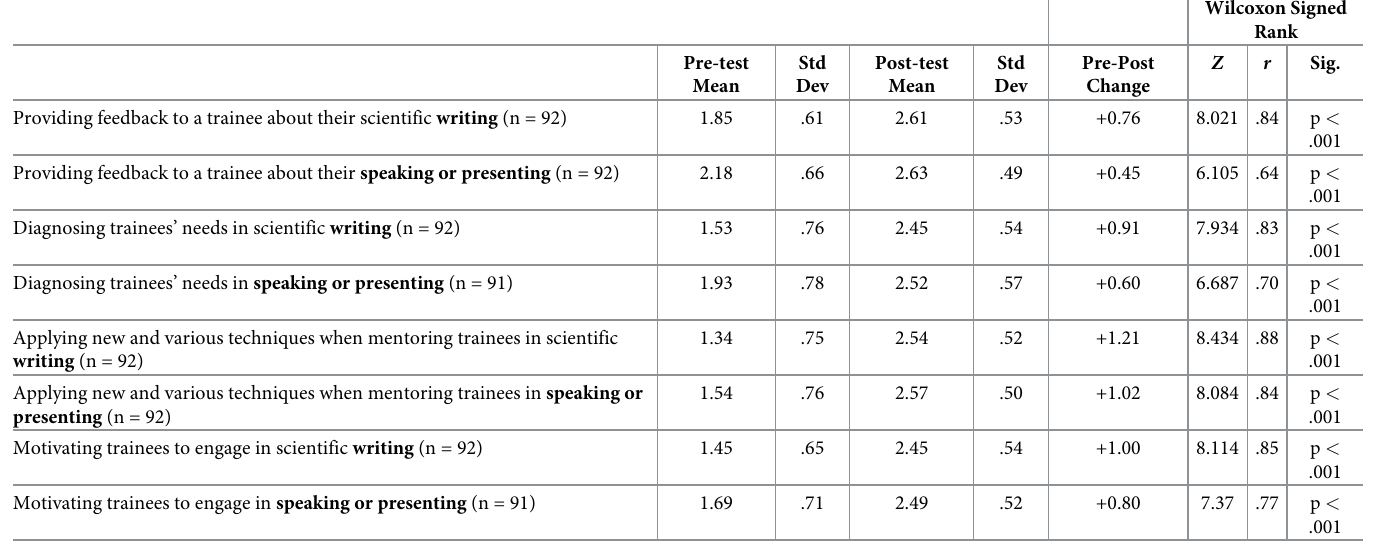
Table 6. Change in Year 2 participant level of skill in SC mentoring